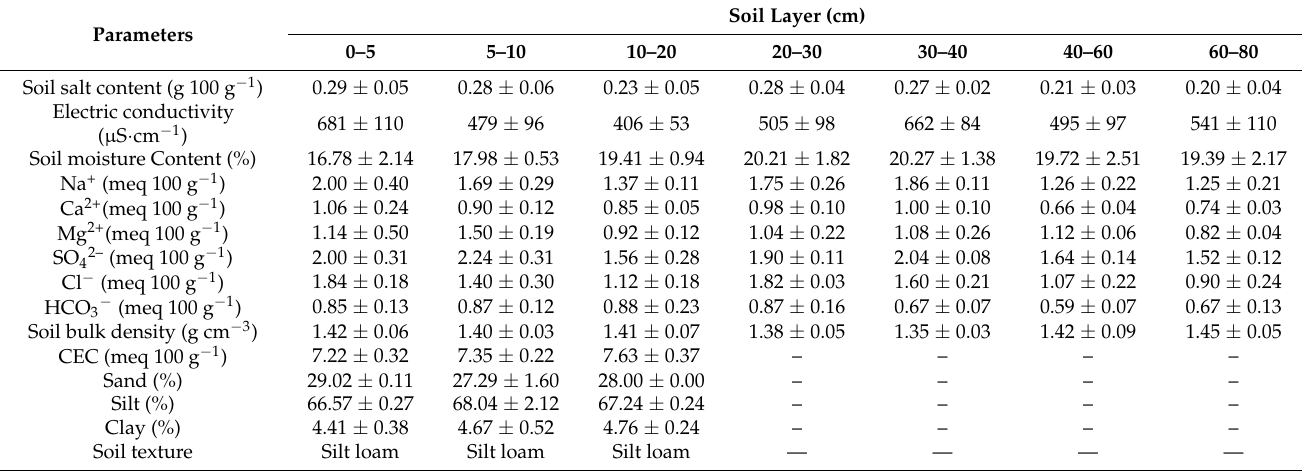
Table 1. Soil basic physicochemical properties before the